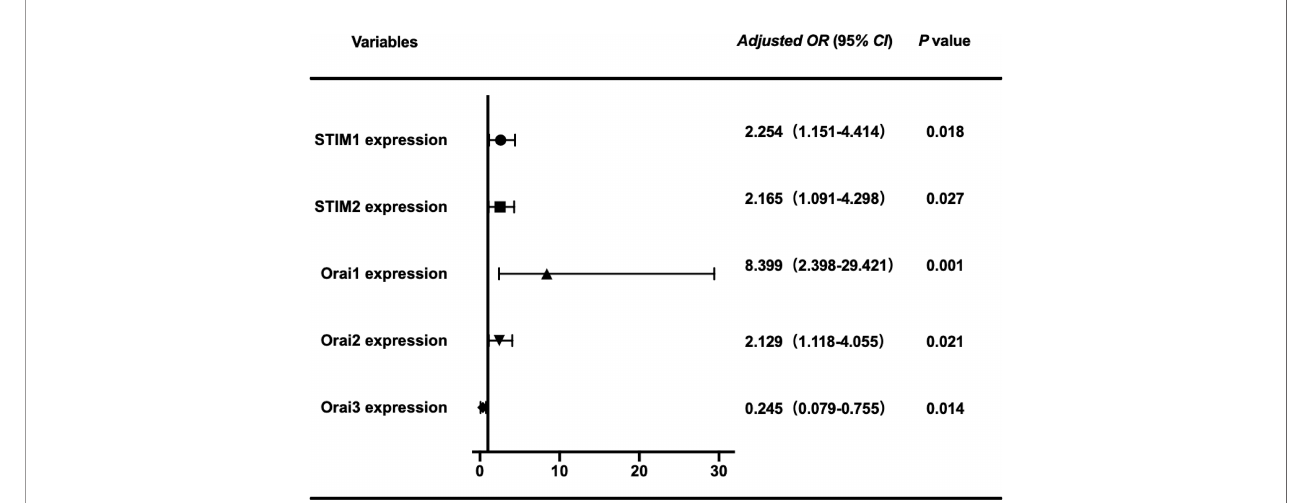
FIGURE 2 | Logistic regression analysis of gene expression after adjusting for age and BMI.